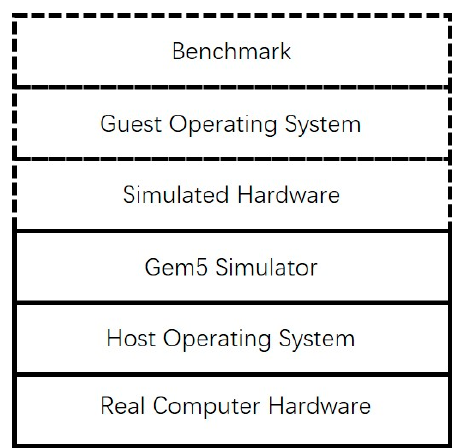
Figure 10. Abstraction level of the simulation system.